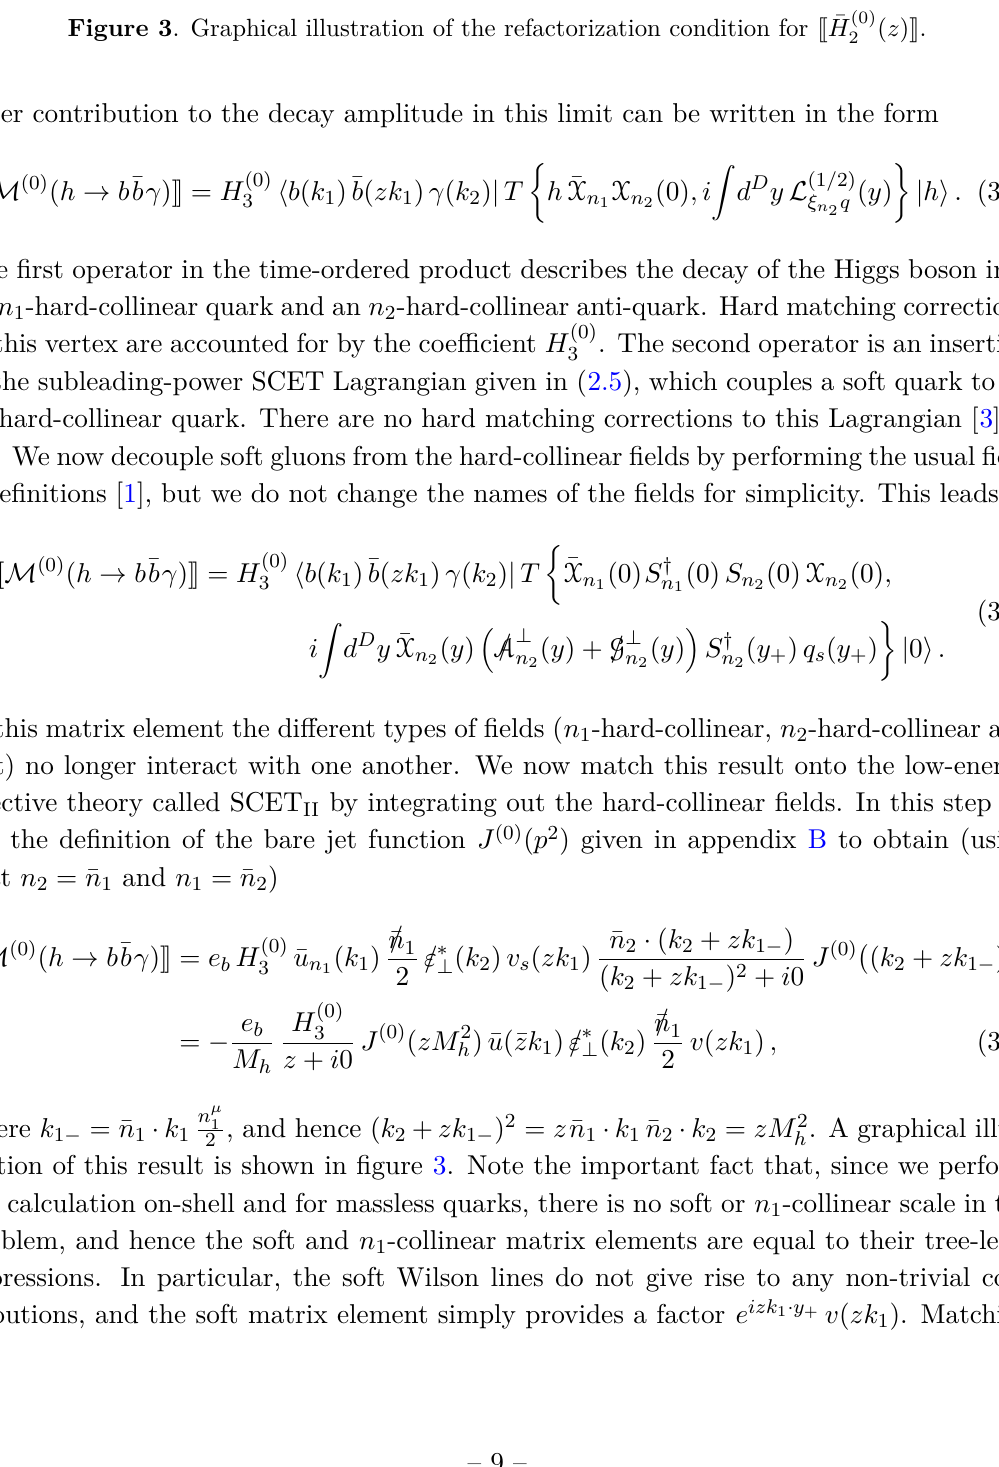
Figure 3 . Graphical illustration of the refactorization condition for [[ ¯ H (0)